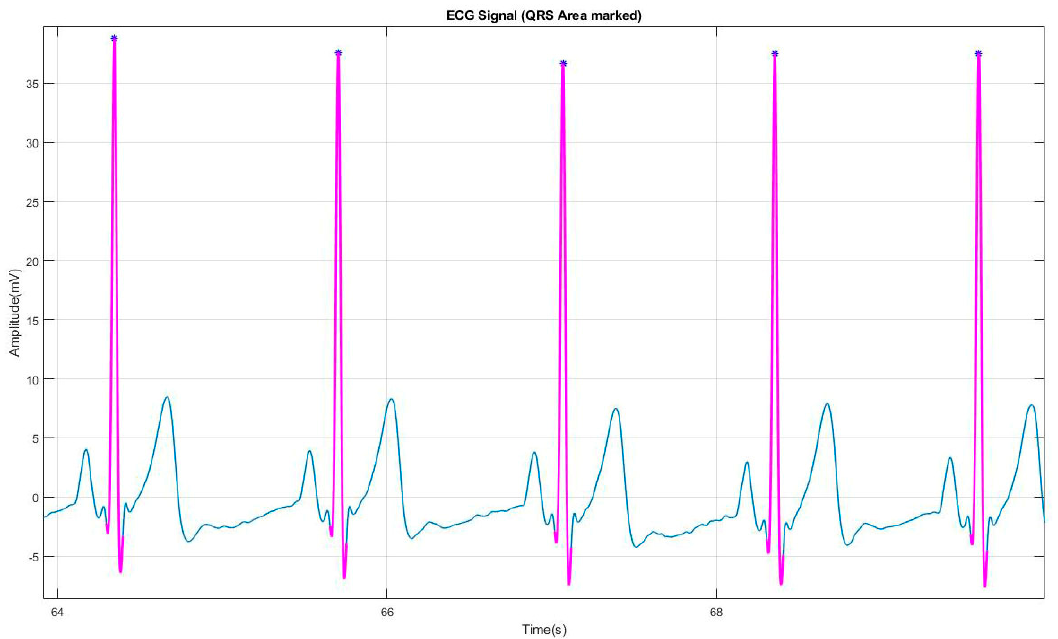
Figure 4. Representation of QRS segmented area in the ECG signal.